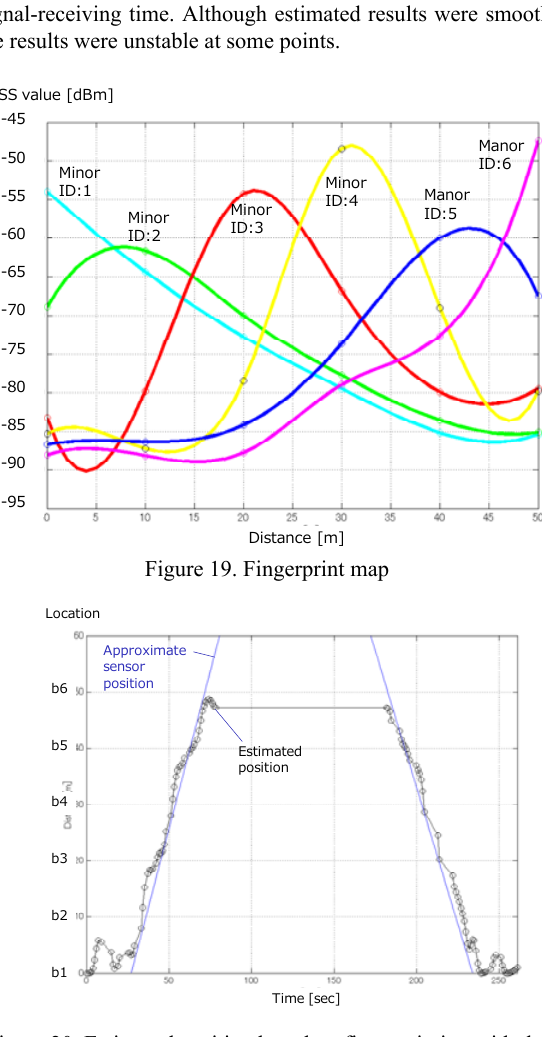
Figure 20. Estimated position based on fingerprinting with the spline